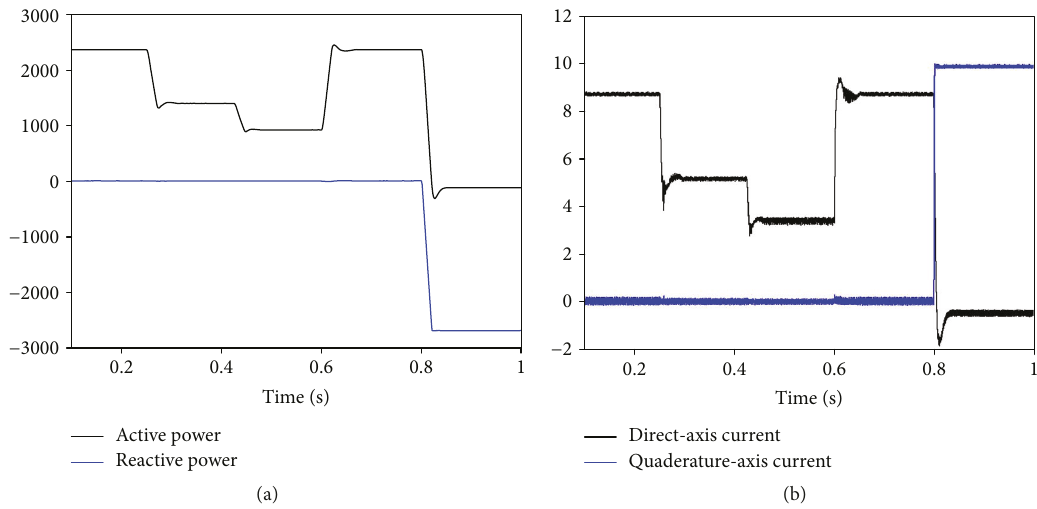
Figure 30: Response to changes in solar radiation. (a) Output active and reactive power, and (b) direct and quadrature axis